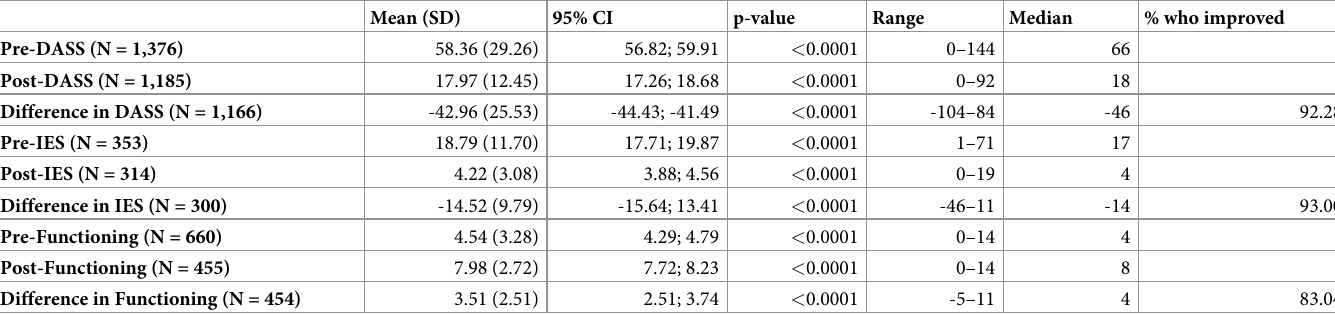
Table 3. Distress and functioning pre- and